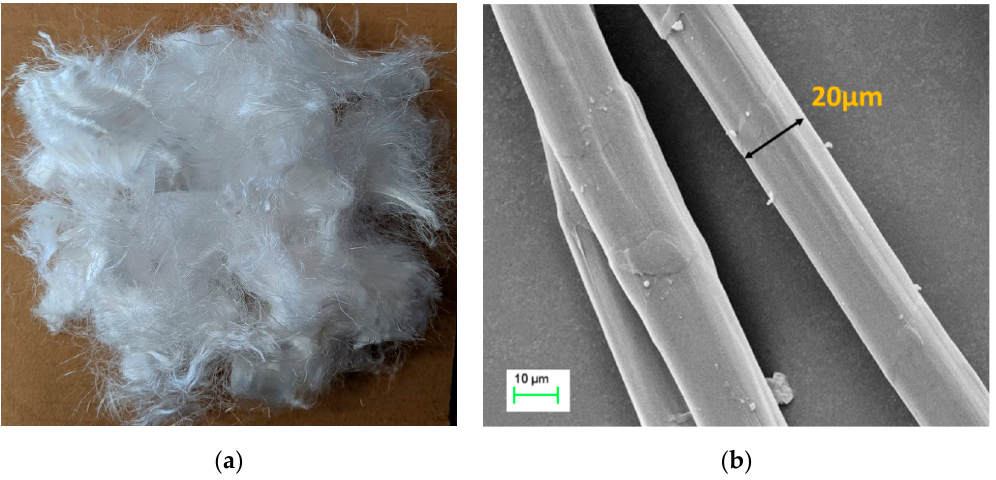
Table 1. Properties of polyethylene (PE) fibre.